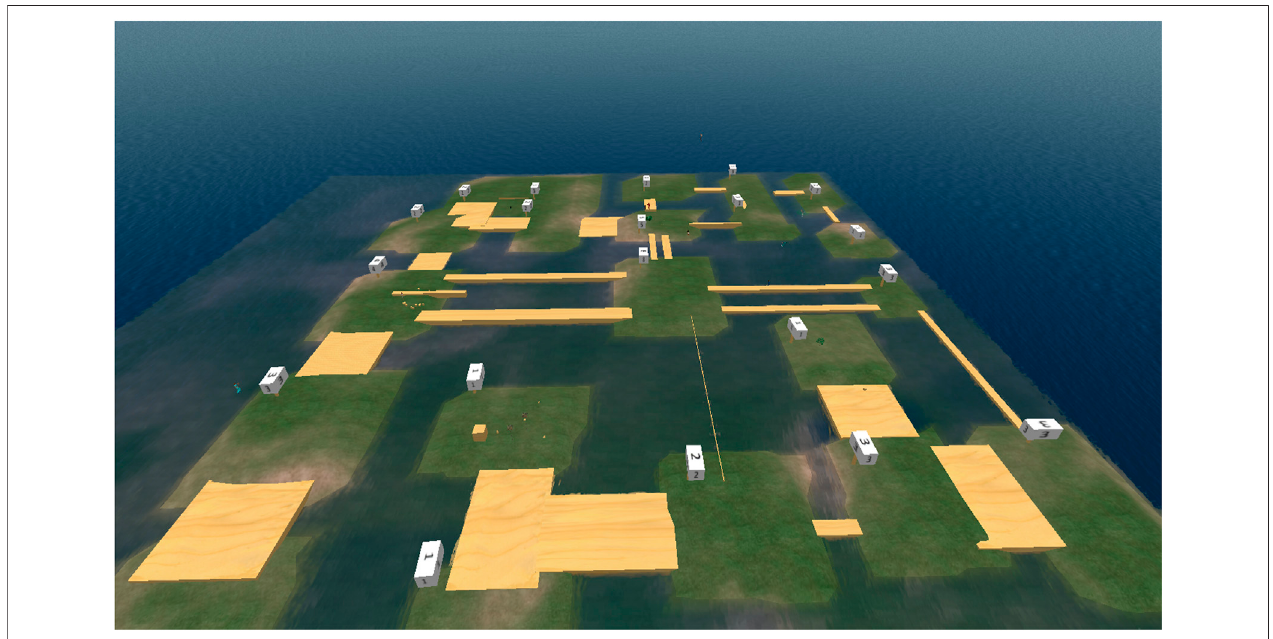
FIGURE 3 | Overview of SORBET environment showing similarity to Hashiwokakero